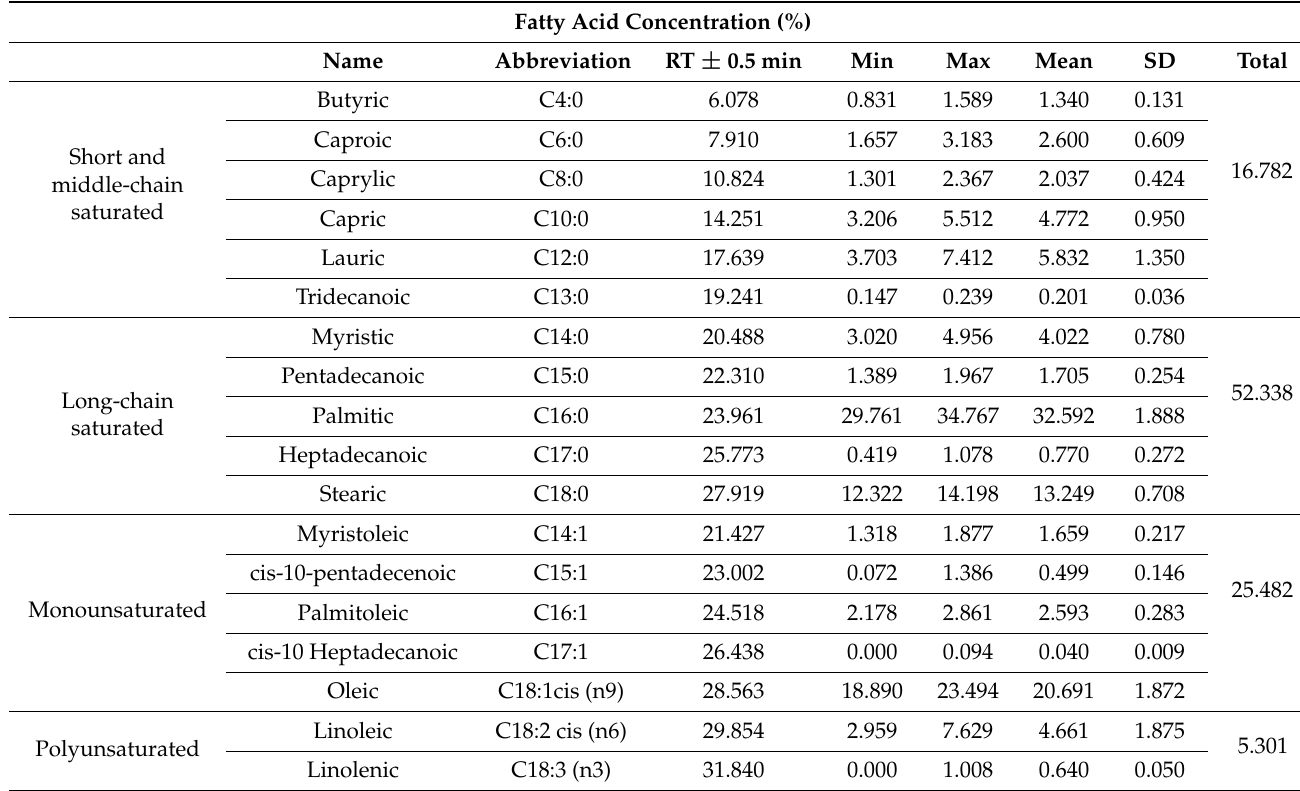
Table 4. The fatty acids composition (%) of fat butter samples. Fatty Acid Concentration